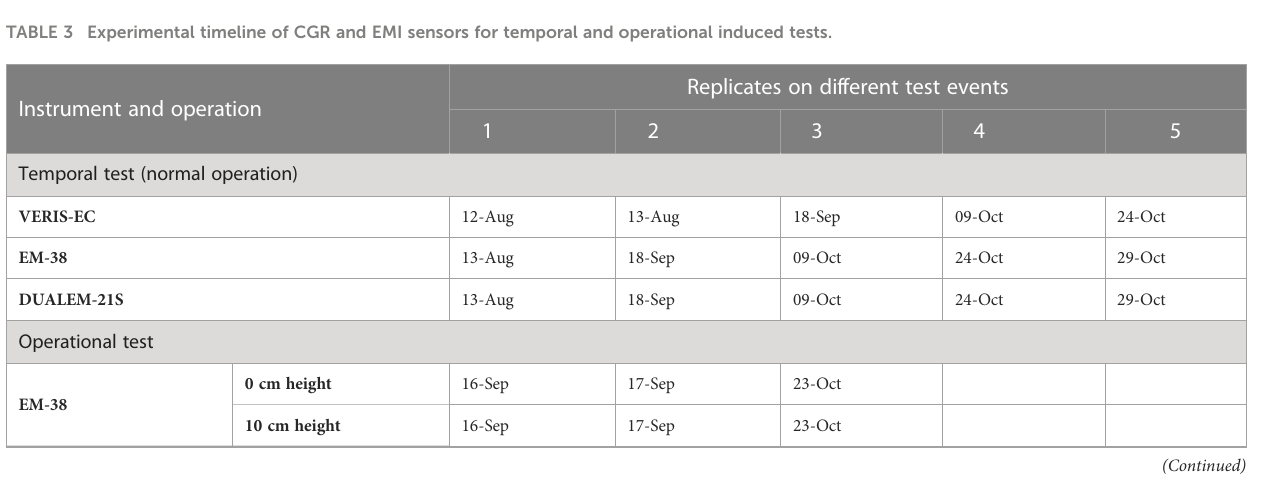
TABLE 3 Experimental timeline of CGR and EMI sensors for temporal and operational induced tests.